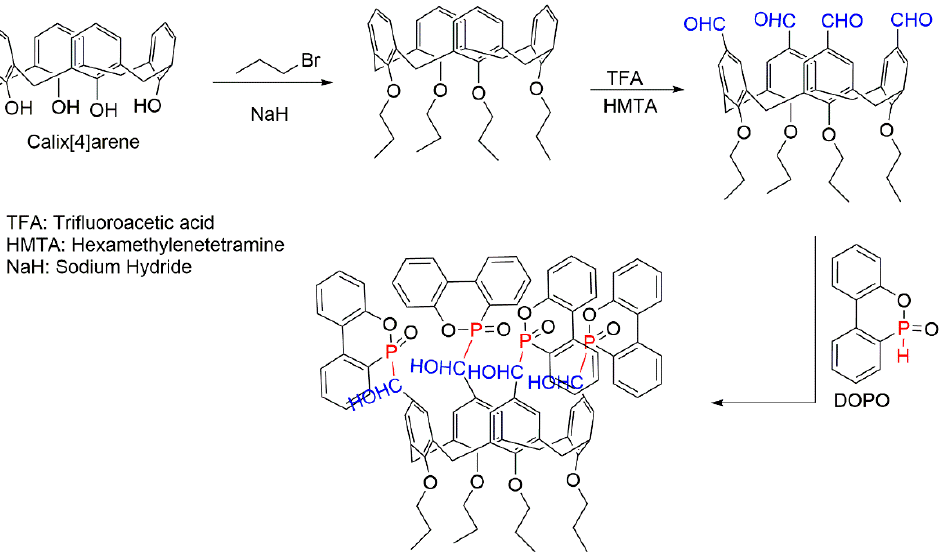
Figure 6. Synthesis of a novel FR based on calixarene and 9,10-dihydro-9-oxa-10-phosphaphenanthrene-10-oxide (DOPO) [62].